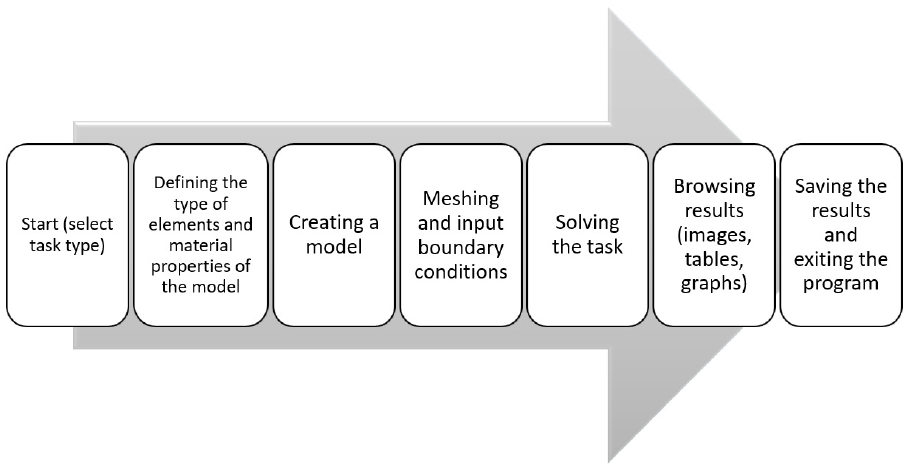
Figure 7. The procedure for solving a computer simulation in ANSYS.